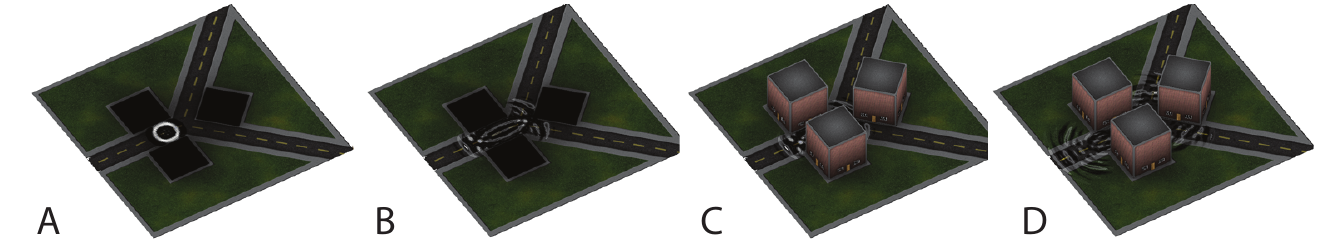
Figure 18. Test scene geometry and the evolution of wave propagation effect in time. Parts (A) and (B) omit buildings to help in visualizing wave reflection. Parts (C) and (D) present the complete scene.